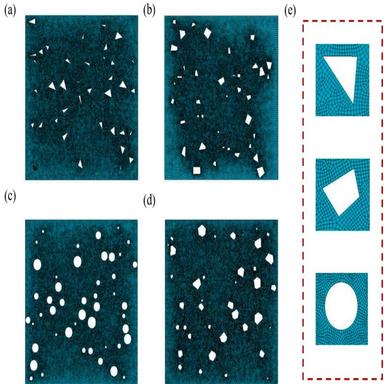
FE models considering the shape effect of micro-voids: (a) triangle, (b) quadrangle, (c) circle, (d) hexagon and (e) refined mesh diagram.